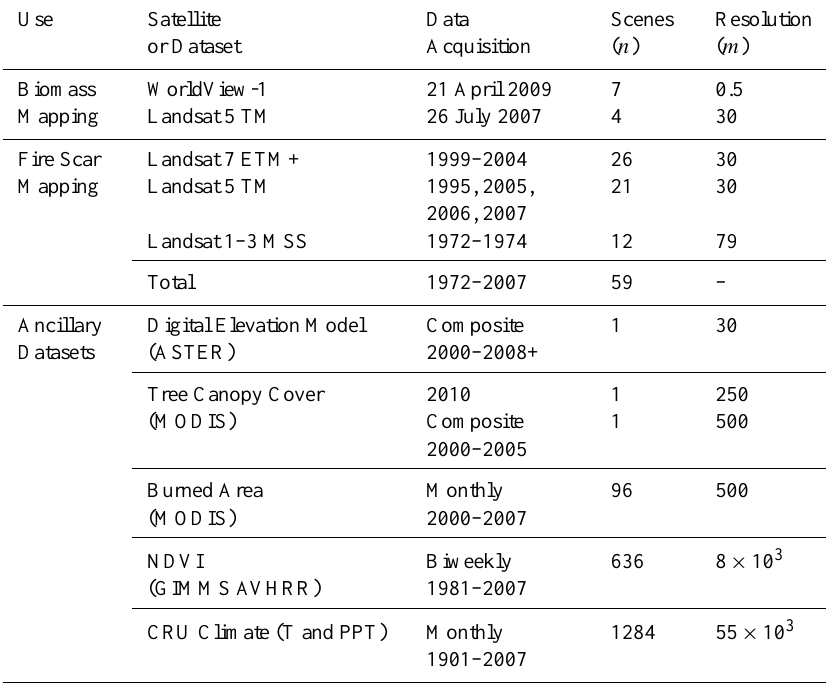
Table 1. Details of the satellite imagery and ancillary geospatial datasets that we used for mapping and analysing larch biomass distribution, forest fires and forest biomass recovery after fire in northeastern